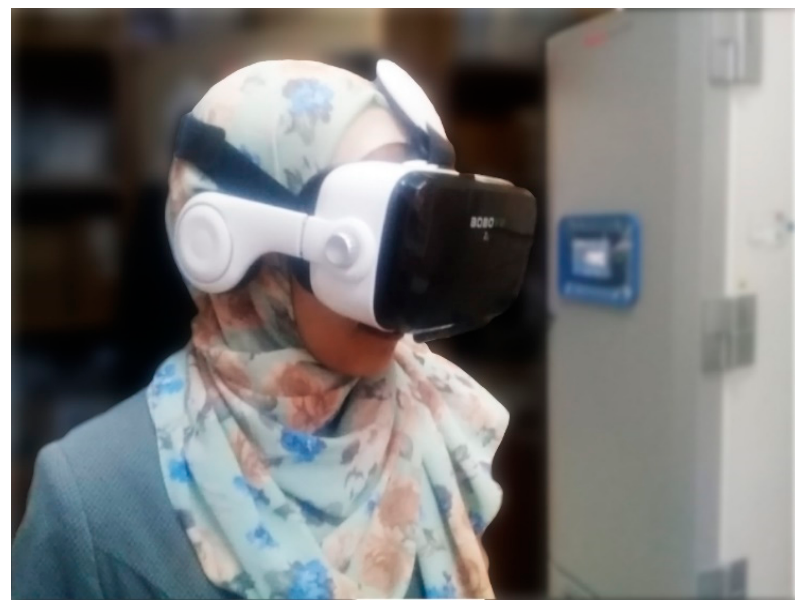
Figure 7. A student uses her smartphone and a low-cost HMD device to use the MedChemVR educational game during the evaluation process.